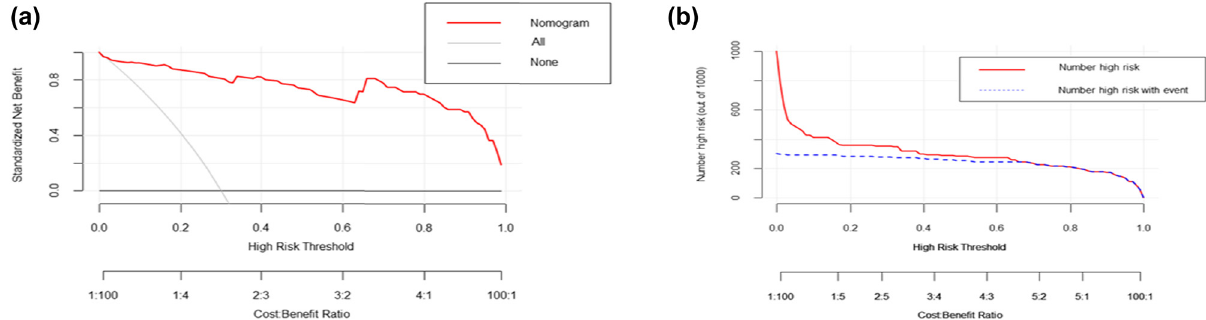
Figure 5: The decision curve and clinical impact curve analysis of the nomogram for predicting severe HFRS. ( a ) The DCA compares the clinical net bene fi ts of scenarios that predict the probability of severe HFRS: a perfect predictive model ( solid grey line ) , no screening ( horizontal solid black line ) , and screening based on the nomogram ( solid red line ) . The y - axis measures the net bene fi t. DCA shows that using nomogram to predict the risk of severe HFRS can bene fi t patients if the threshold probability of the patient or doctor is between 0 and 1. ( b ) Clinical impact curve of the nomogram plots the number of HFRS patients classi fi ed as high risk, and the number of cases classi fi ed as high risk with the event at each risk threshold. HFRS, hemorrhagic fever with renal syndrome; DCA, decision curve